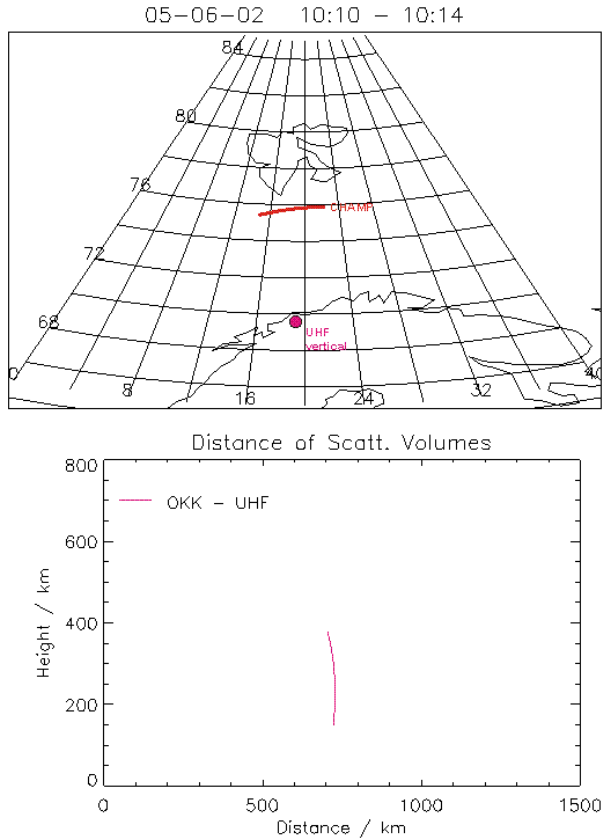
Fig. 6. Upper panel: Projection of the occultation trace on the ground and the location of the EISCAT UHF radar (Tromsø) in a latitude-longitude graph. Lower panel: Distance between the points of the occultation path and the radar scattering volumes at the same altitude.